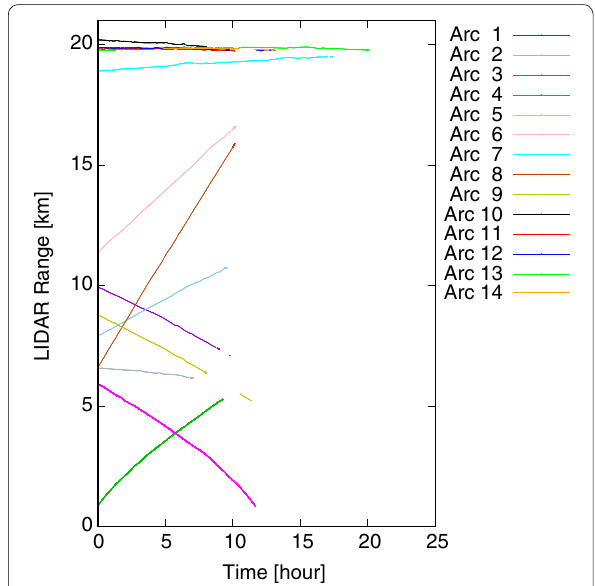
Fig. 1 Temporal change of LIDAR‑observed altitude for each arc.